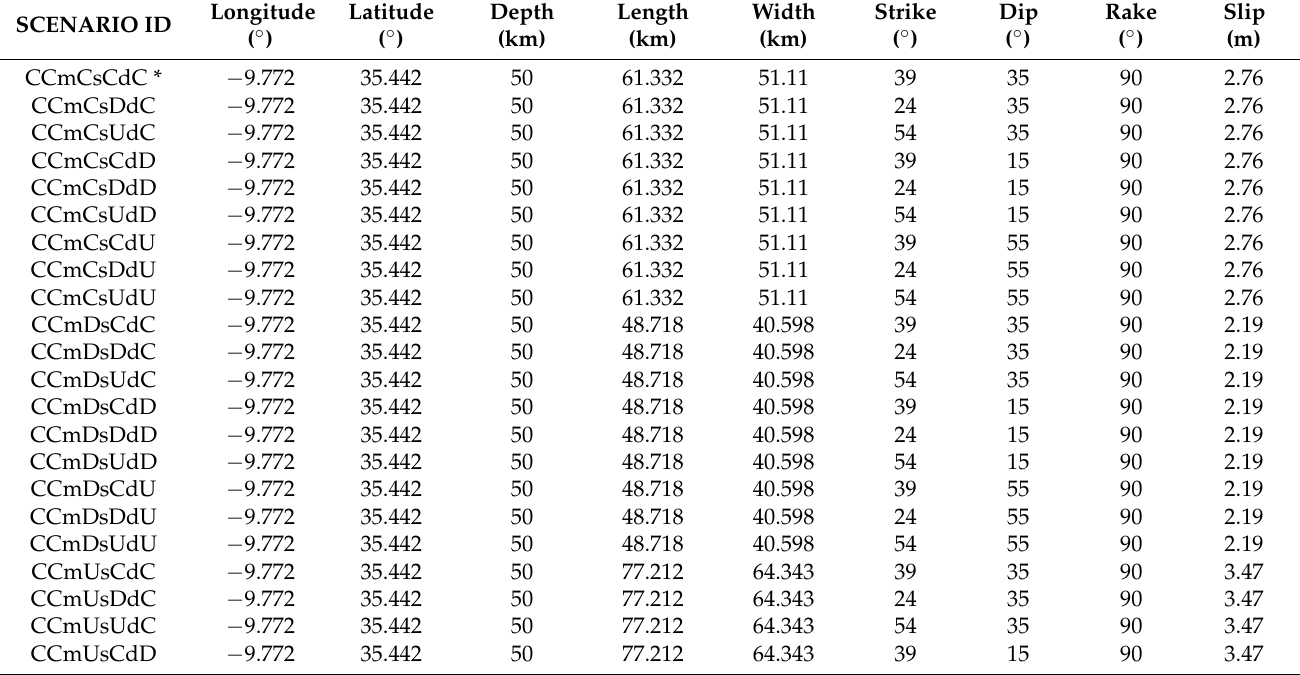
Table A1. List of scenarios and input source parameters to the Tsunami-HySEA model used to compute the results of this